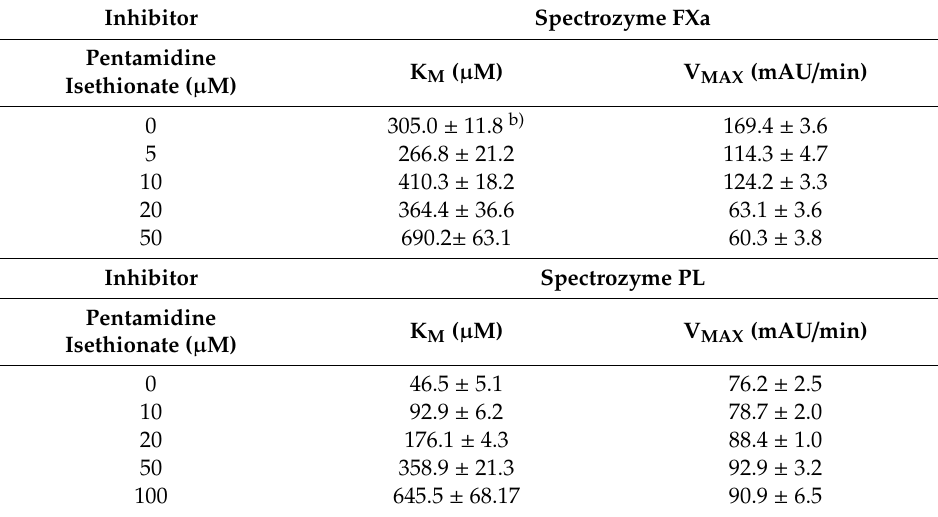
Table 3. Hydrolysis of the chromogenic substrate Spectrozyme FXa by human FXa and Spectrozyme PL by human plasmin in the presence of pentamidine isethionate.